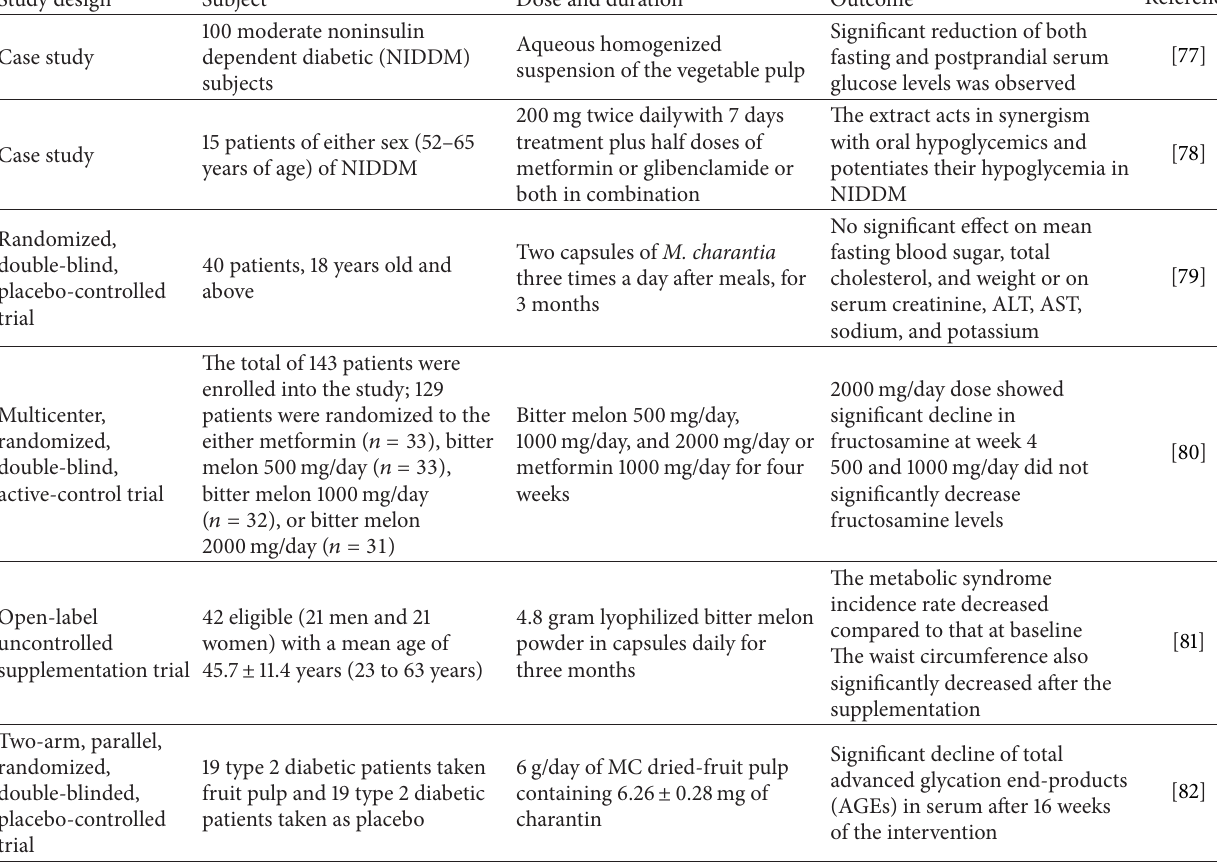
Table 3: Clinical studies of bitter melon